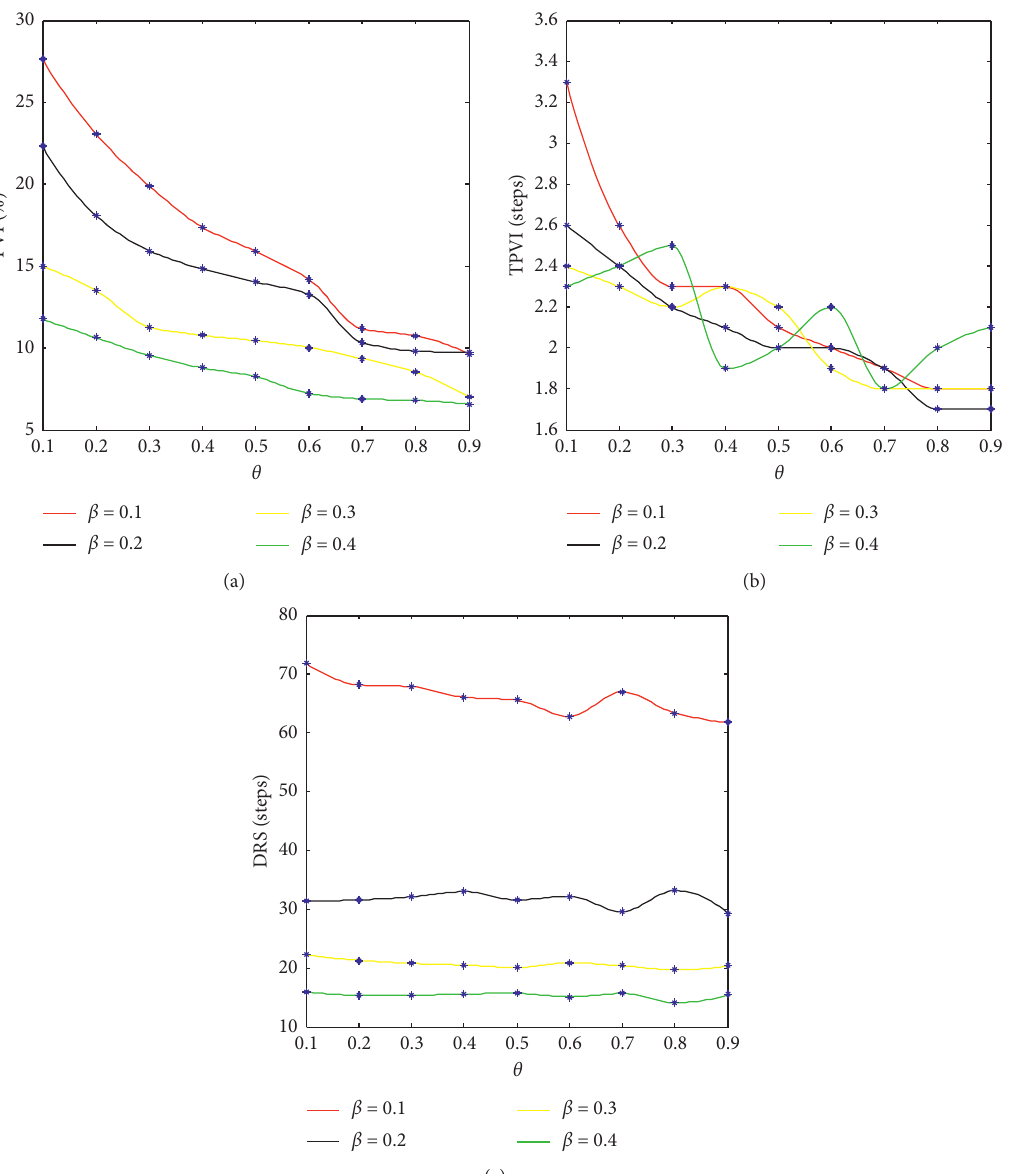
Figure 4: Influence of changes of forgetting rate β and self-purification level θ on above three indicators PVI, TPVI, and DRS. Simulations are conducted under the condition α � 0 . 5, a 0.4), (b) TPVI change, and (c) DRS